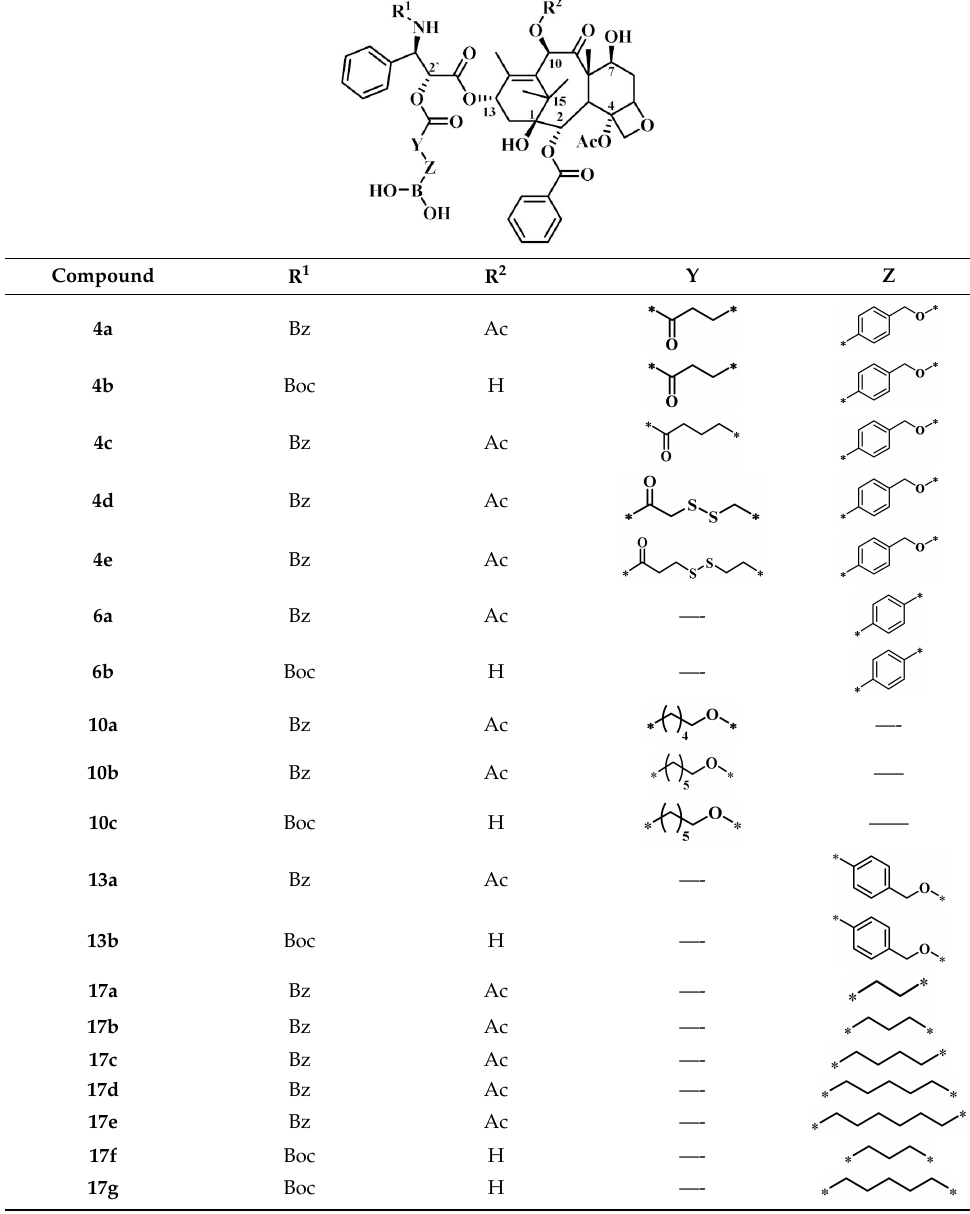
Table 1. The chemical structures of compounds 4a–4e , 6a–6b , 10a–10c , 13a–13b and 17a–17g .